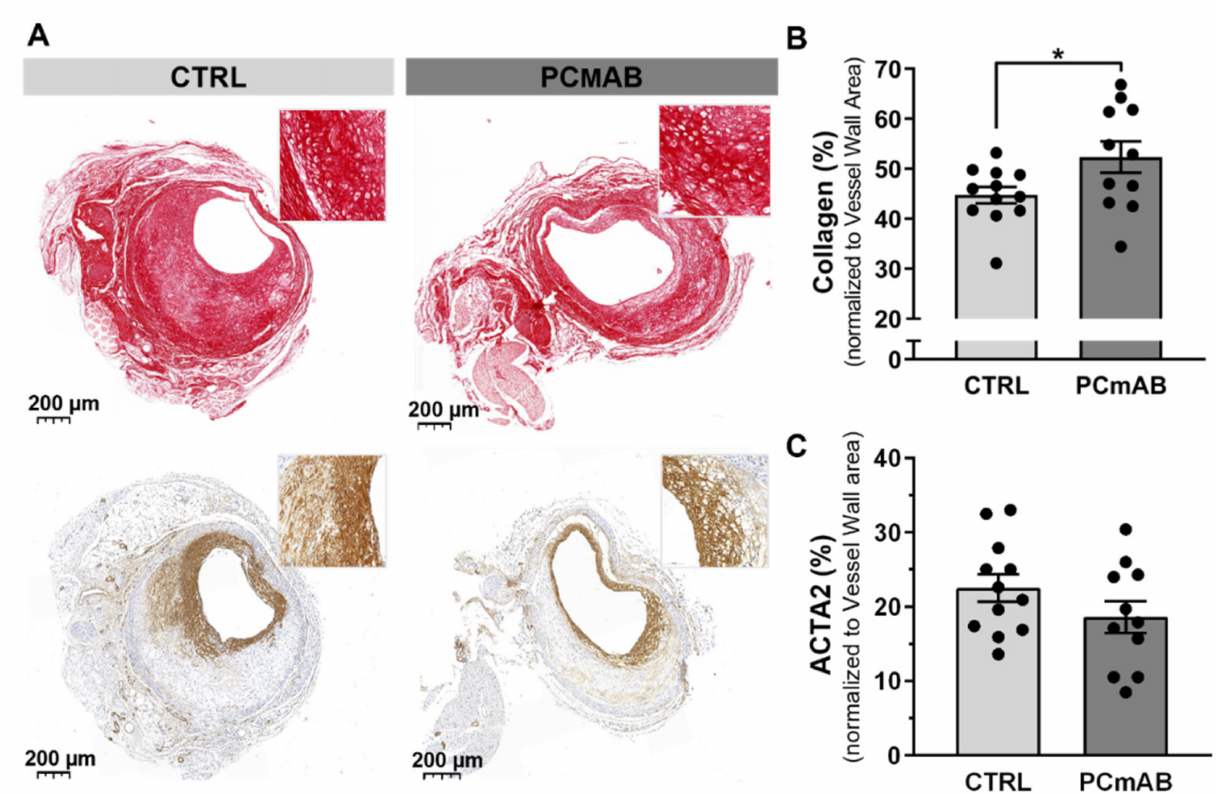
Figure 2. PC-mAb improves plaque stability by increasing collagen content in vein graft atherosclero- sis. Representative vein grafts cross sections ( A ) of Sirus Red Staining, Actin alpha 2 (ACTA2) and Masson Trichrome of CTRL (n = 12) and PC-mAb group (n = 11). Quantitative measurements of % Collagen ( B ), % ACTA2 area ( C ). Data presented as mean ± SEM. * p ≤ 0.05 by t